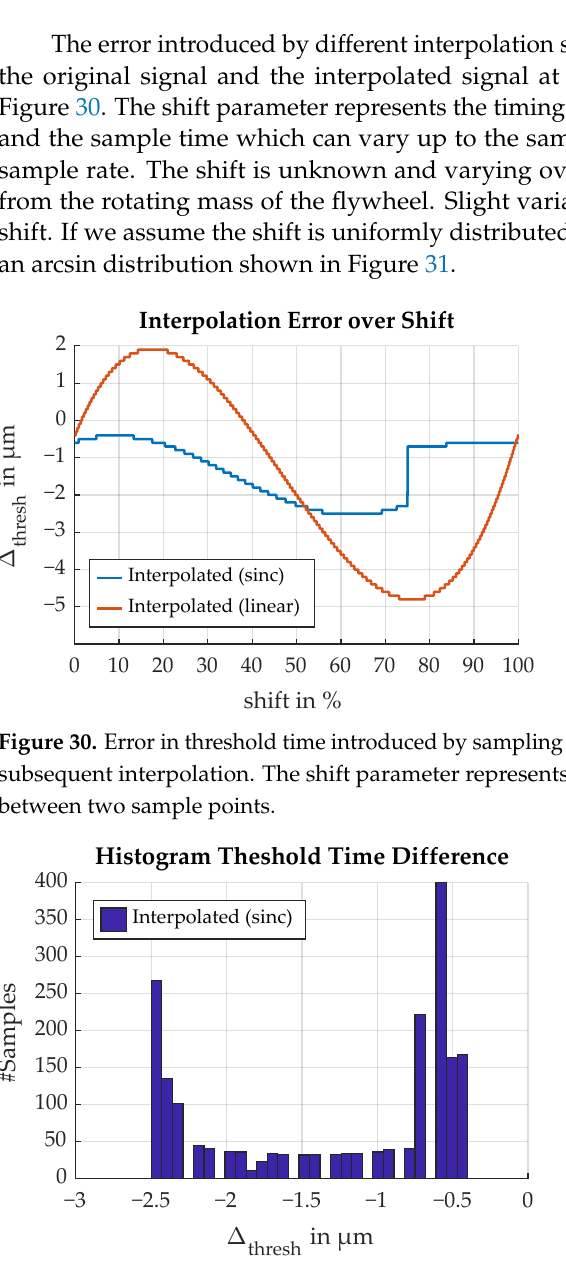
Figure 31. Distribution of the error introduced by sampling the edge transition function 5MS/s and subsequent